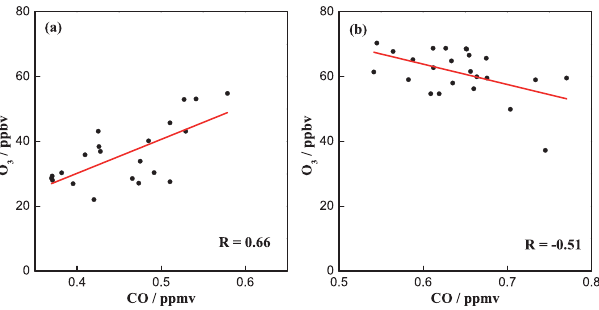
Figure 6. Correlations between measured surface CO and O 3 over two periods respectively (a) from 12:00 11 June to 12:00 12 June and (b) from 12:00 13 June to 12:00 14 June 2014, passing the significant level of 0.005. Red lines are the linear